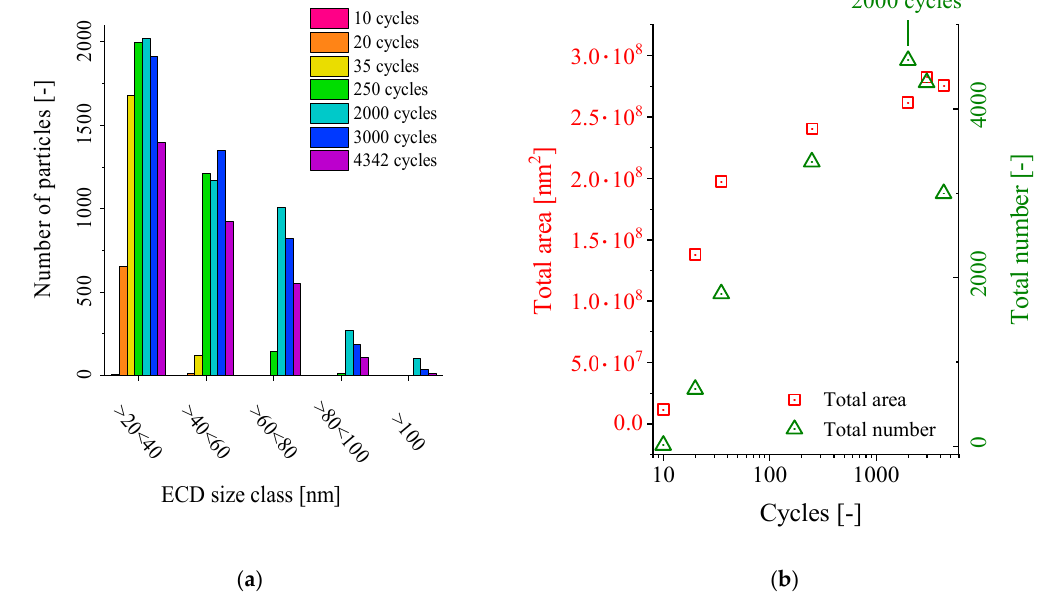
Figure 8. Evolution of Laves phase particle population in ferritic Crofer ® 22 H steel during TMF cycling: Size classification by equivalent circle diameter (ECD) ( a ) total particle area and number ( b ).